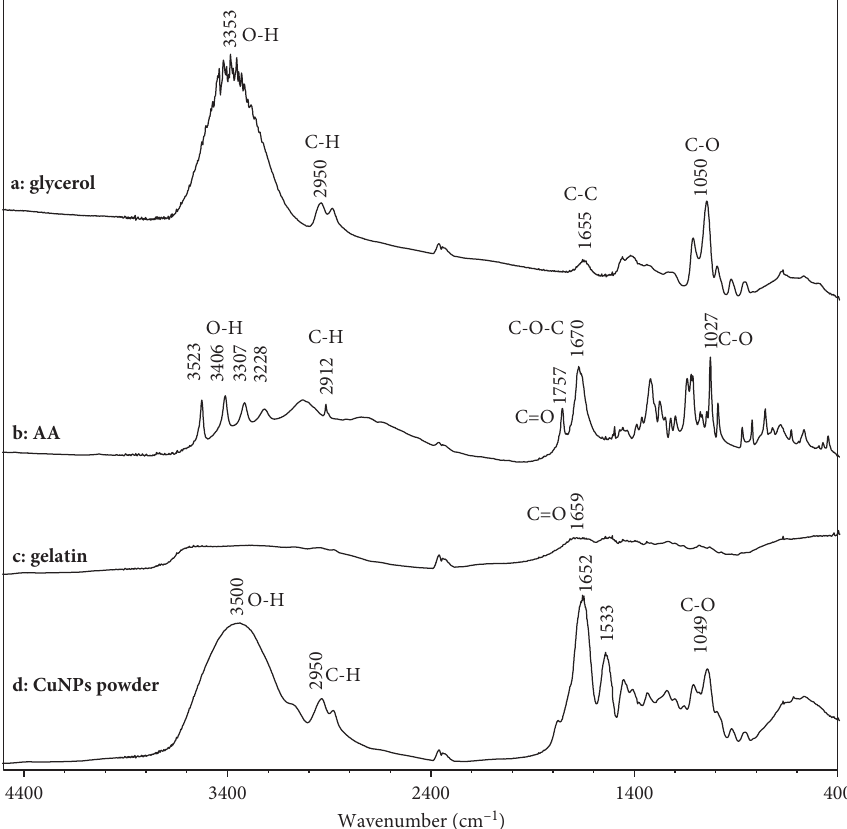
Figure 5: ATR-FTIR spectra of glycerol, AA, gelatin, and CuNPs-containing